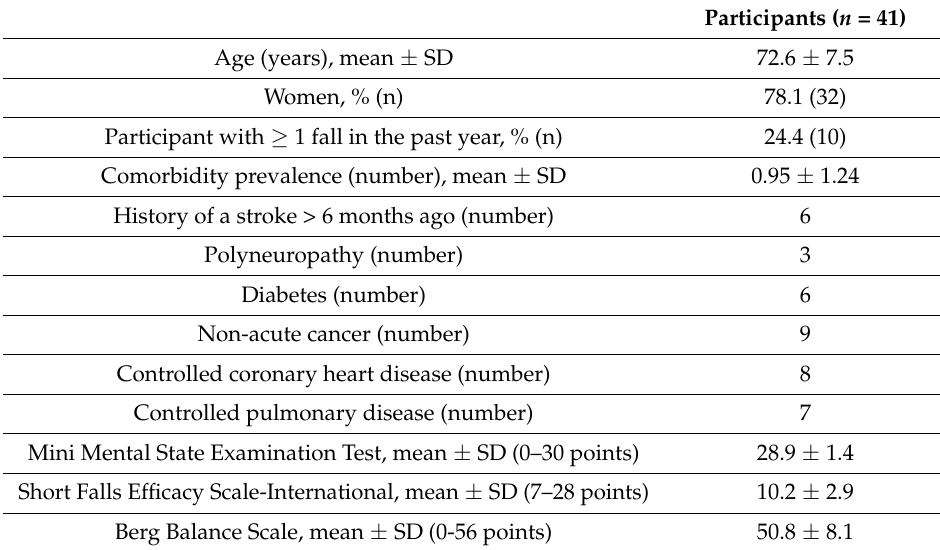
Table 1. Participant characteristics.